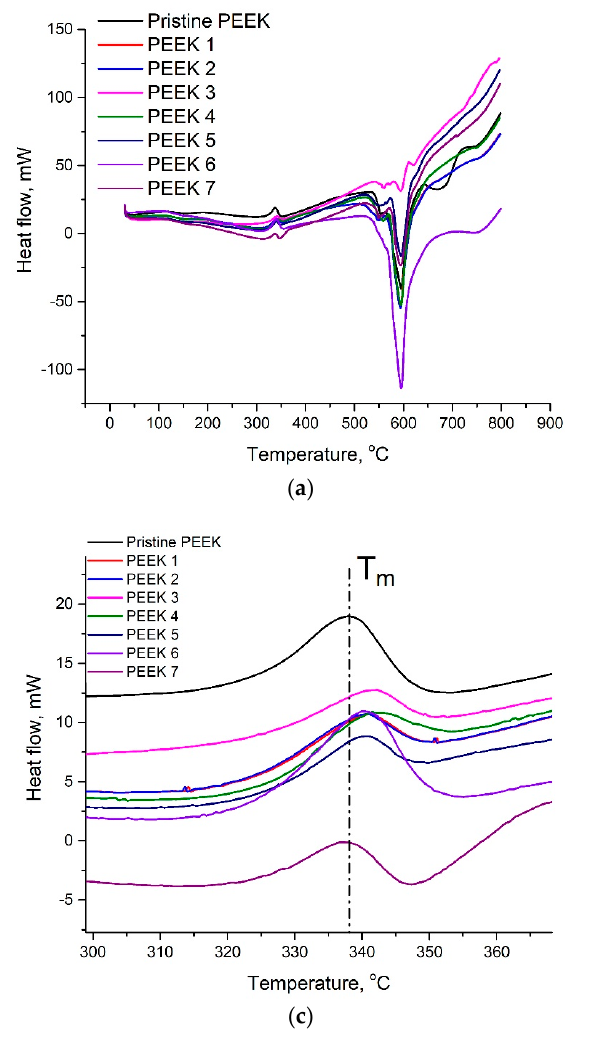
Figure 8. DSC curves of the pristine and irradiated PEEK samples ( a ). ( b ) Glass transition, ( c ) melting, and ( d ) weight loss